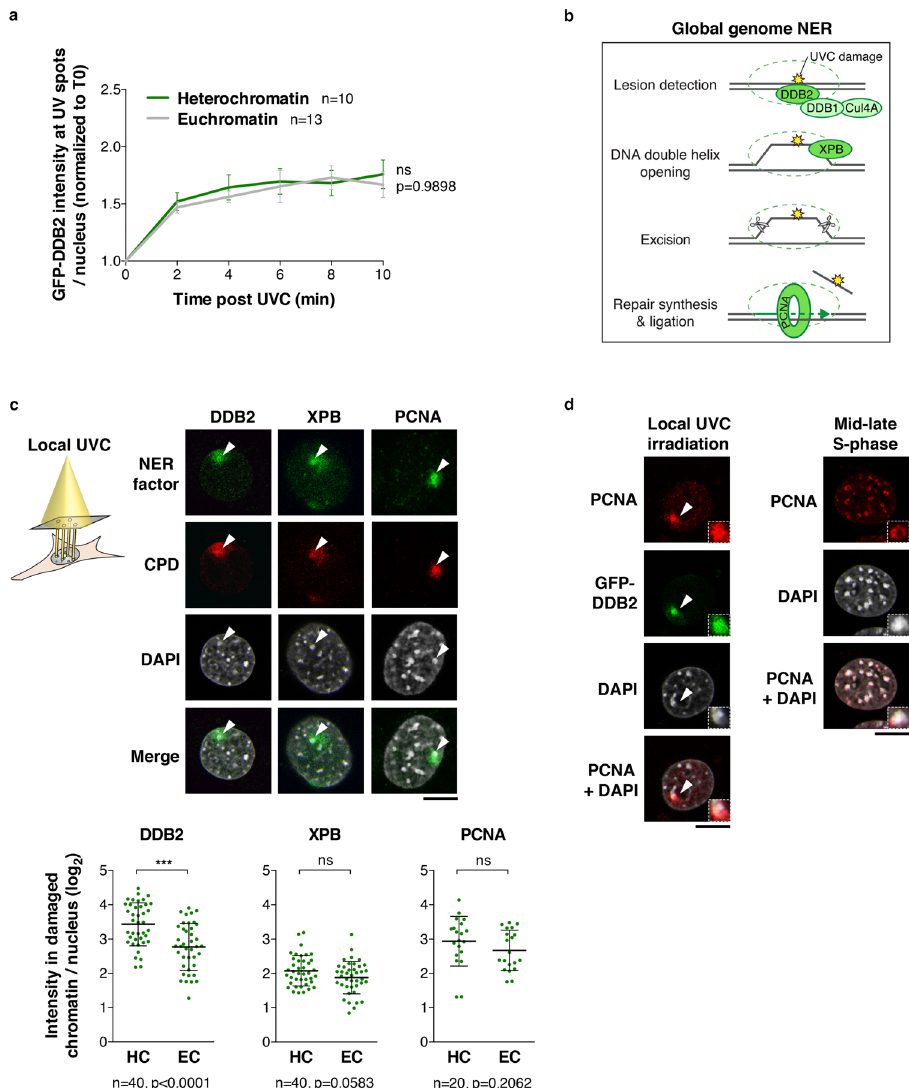
Fig. 4 The NER pathway operates within heterochromatin domains. a Kinetics of DDB2 recruitment to damaged euchromatin and heterochromatin analyzed in NIH/3T3 GFP-DDB2 cells after UVC laser damage. b Scheme of the Global Genome Nucleotide Excision Repair factors studied. c Recruitment to UVC damage (CPD) of early (DDB2), intermediate (XPB) and late (PCNA) repair factors, analyzed by immuno fl uorescence 30 min after local UVC irradiation through micropore fi lters in NIH/3T3 GFP-DDB2 cells. Cells with damaged heterochromatin domains (white arrowheads) were selected for the analysis. PCNA accumulation to damaged heterochromatin was analyzed outside S-phase. XPB and PCNA were not stained in green because the cells express GFP-DDB2, but are presented in green for simplicity. Scatter plots represent log2 fold enrichments of repair proteins in damaged heterochromatin (HC) and damaged euchromatin (EC) compared to the whole nucleus. d Accumulation of PCNA within heterochromatin domains upon local UVC irradiation and con fi ned to the periphery of replicating heterochromatin in mid-late S-phase. Similar results were obtained in two independent experiments. Data are presented as mean values ± SD from n cells scored in at least two independent experiments. Comparisons of GFP-DDB2 kinetics in distinct chromatin domains are based on non-linear regression with a polynomial quadratic model ( a ). Statistical signi fi cance in ( c ) is calculated via two-sided Student ’ s t test. All microscopy images are confocal sections. Scale bars, 10 μ m. Insets show zoomed in views of heterochromatin domains (×2.3). Source data are provided as a Source Data fi